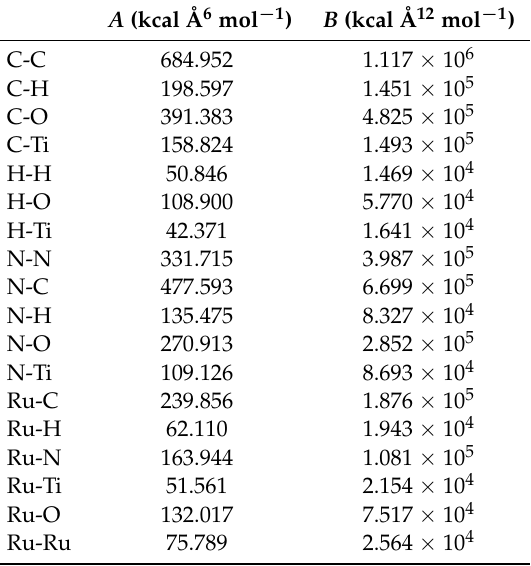
Table A2. Attractive and repulsive Lennard-Jones